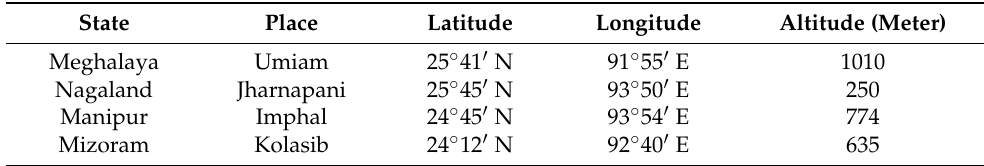
Table 1. Detailed information about various locations of the meteorological observatories in the northeastern hill region of India.